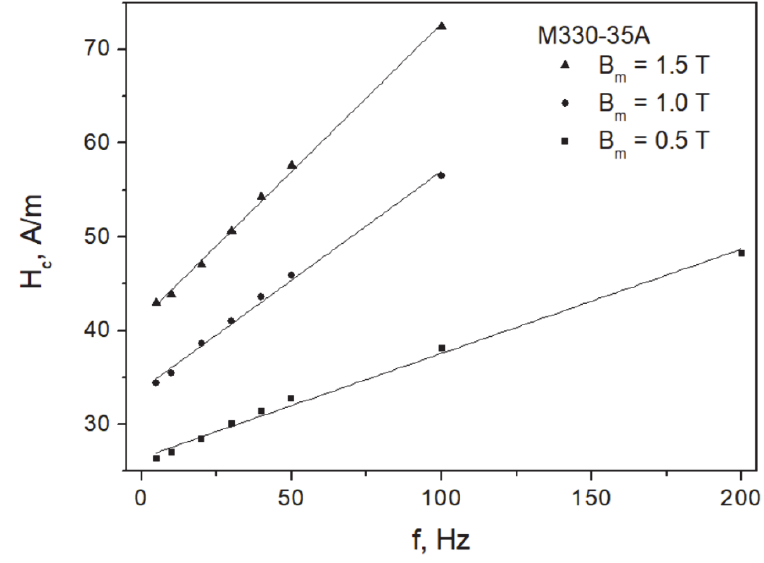
Sensors 2022 , 22 , x FOR PEER REVIEW 9 of 18 = H c ( f ) dependencies for the M330-35A grade. Figure 4. Measured )( cc fHH  dependencies for the M330 ‐ 35A grade. Figure 4. Measured H c